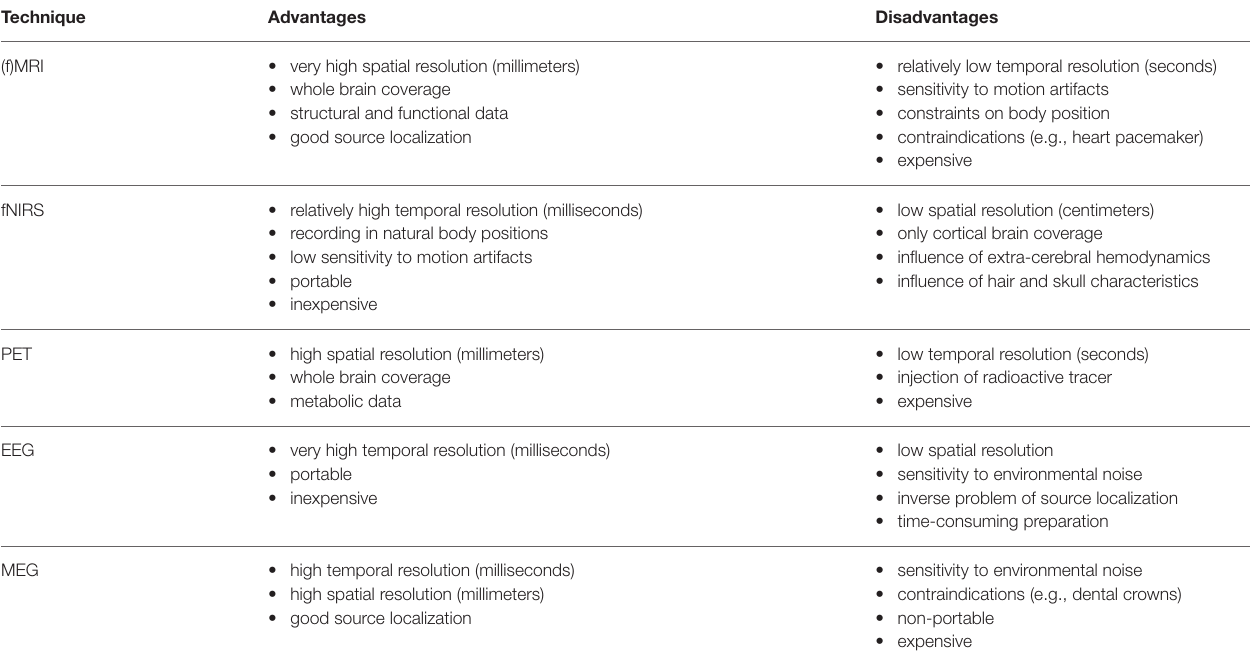
TABLE 1 | Exemplary advantages and disadvantages of common neurocognitive brain imaging techniques.